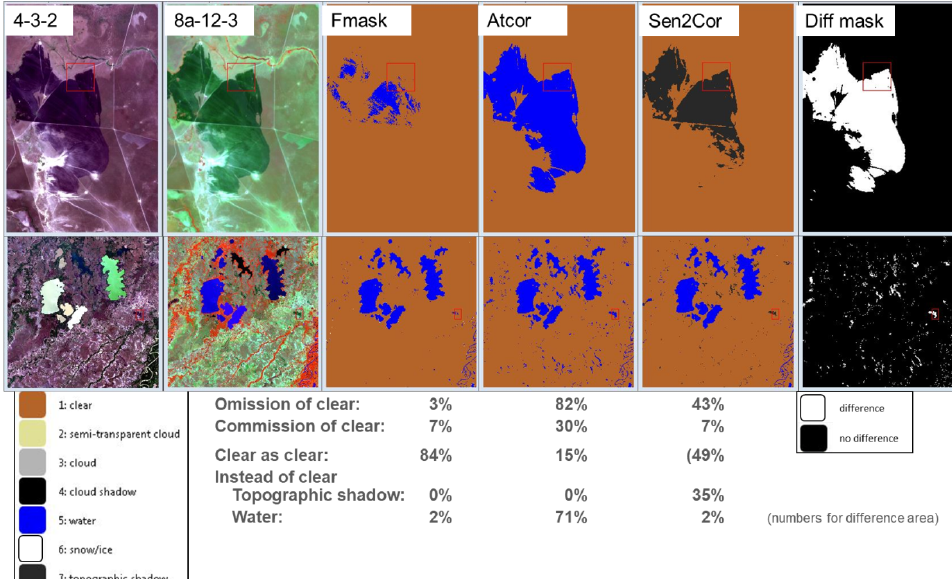
Figure 4. Difference area validation on example of scene 4 (Bolivia, Puerto Siles). Bottom row: Sentinel-2 Scene; top row: zoom of image showing a region with burned area; From left to right: Natural color composite of bands 2, 3, 4; false color composites of bands 8a, 12, 3 helpful for discrimination between dark classes, vegetation types and clouds; Classification map from Fmask; Classification output of ATCOR; Classification map from Sen2Cor; Difference area